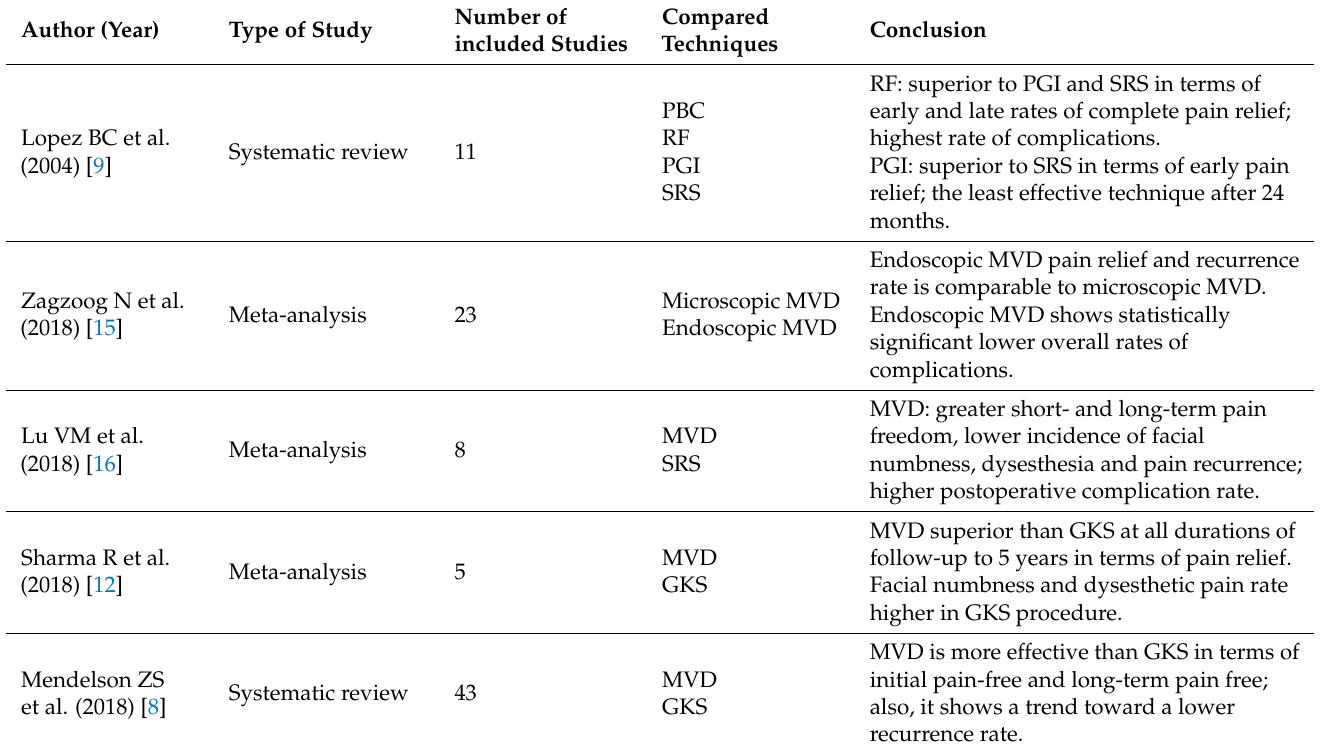
Table 1. Summary of the 10 studies included in this umbrella review.